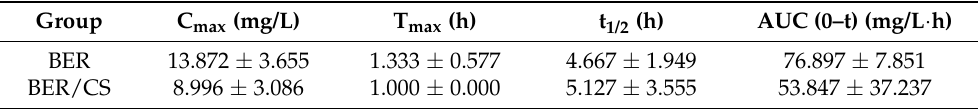
Table 4. Pharmacokinetic parameters of BER and BER/CS ( n = 9).